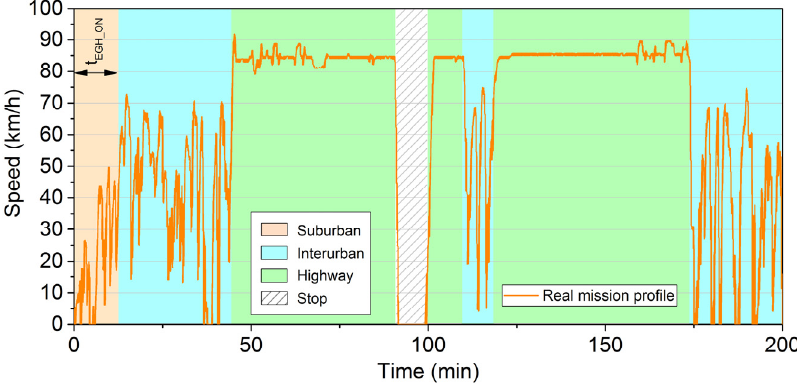
Figure 11. Speed profile of a long-haul heavy-duty vehicle [28].